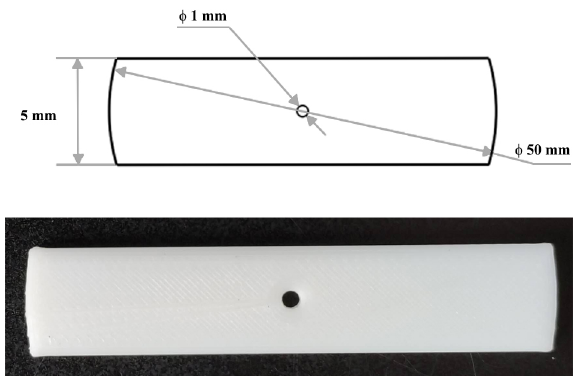
Figure 7. The calibration target used in the experiment.